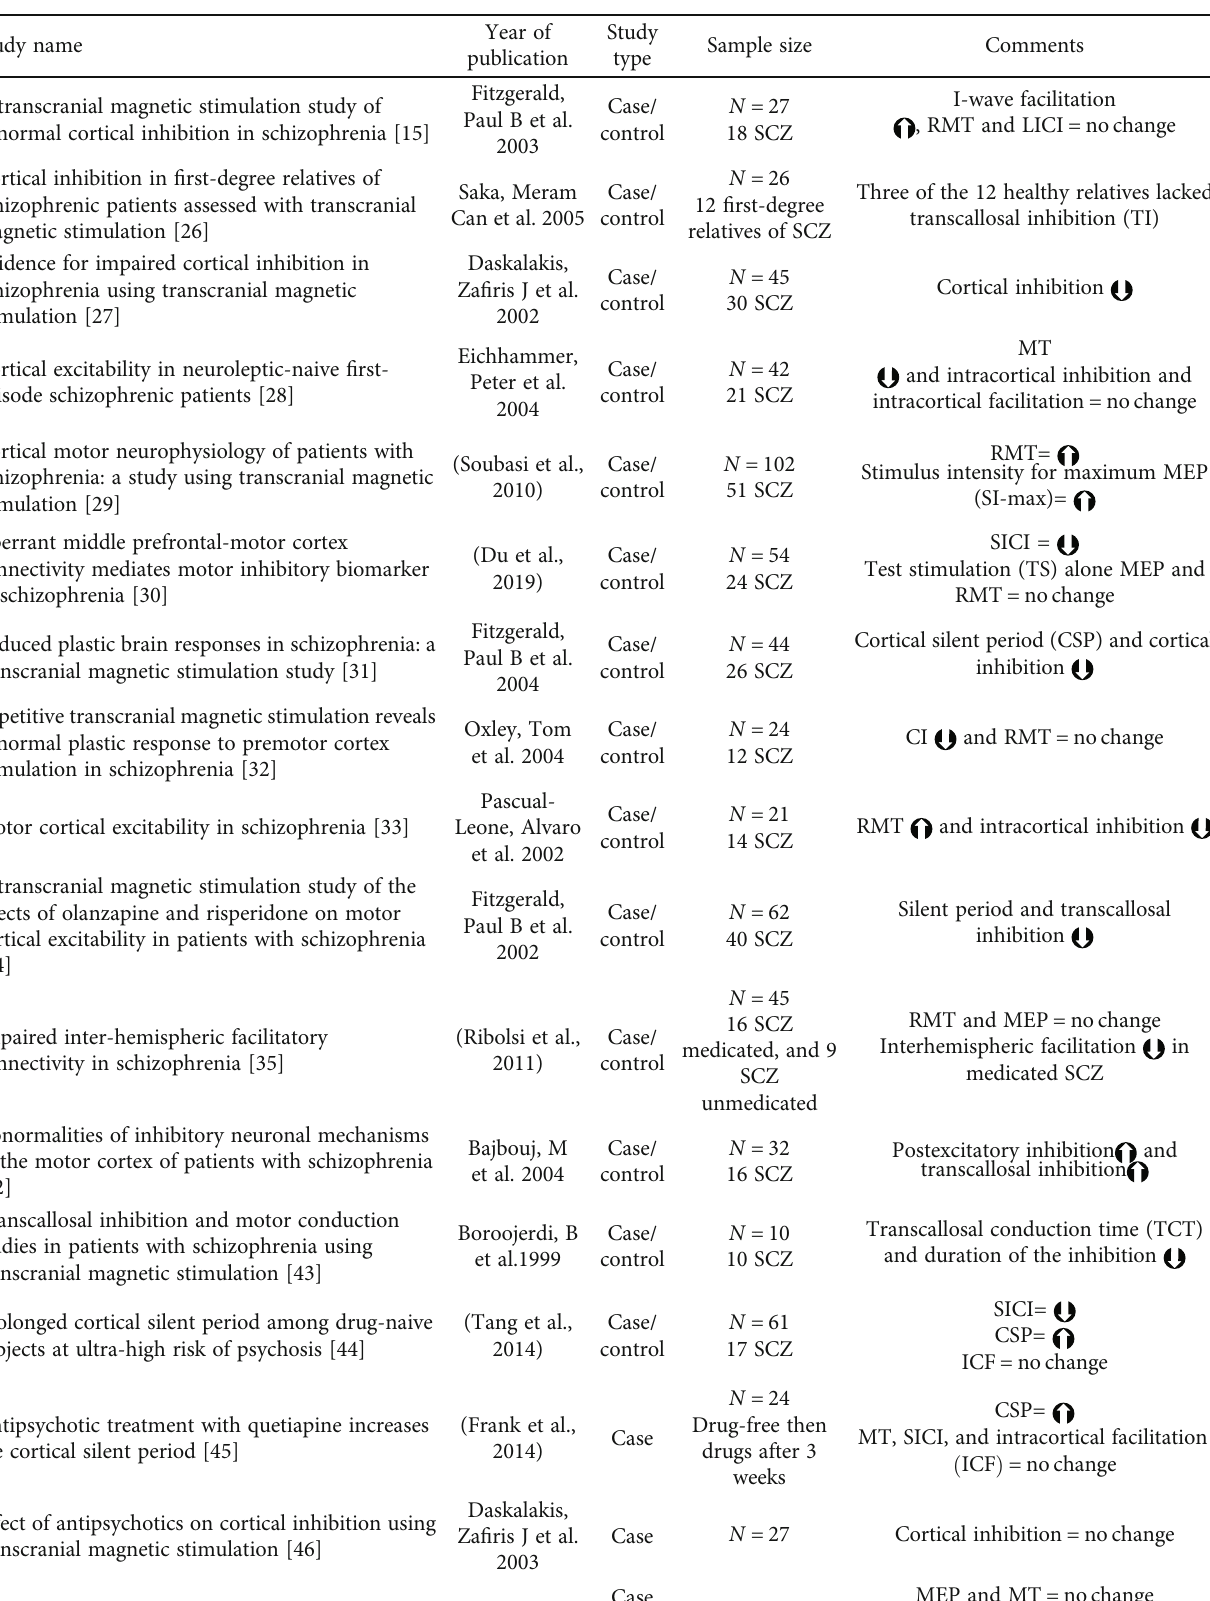
Table 1: Cortical excitability in schizophrenia studies using transcranial magnetic